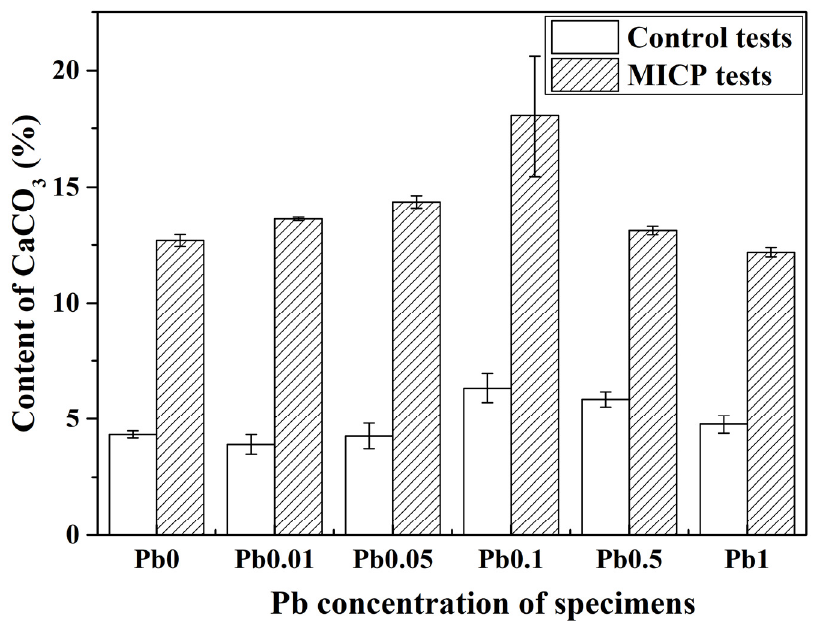
Figure 9. CaCO 3 content of silty soil samples with different Pb concentrations cured by MICP.